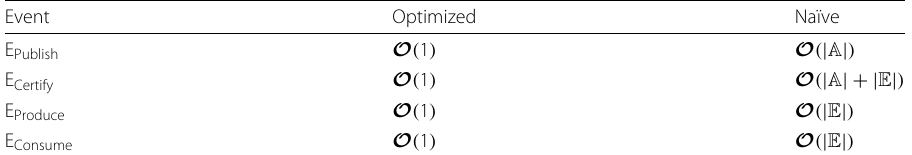
Table 4 Complexity analysis of operations in the Event State Machine when executing the GECKO